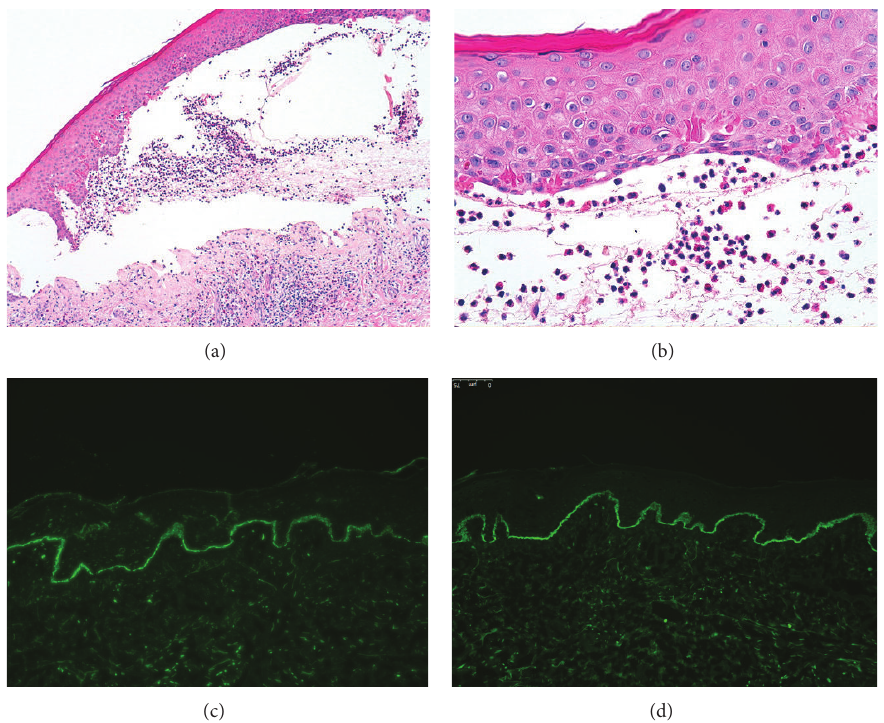
Figure 2: Subepidermal bulla containing eosinophils with an eosinophilic inflammatory cell infiltrate in the superficial dermis (H and E staining, magnification × 100) (a); detail of eosinophils in the subepidermal blister (H and E staining, magnification × 400) (b). Direct immunofluorescence tests show deposition of IgG (c) and C3 (d) at the basement membrane zone (200x).